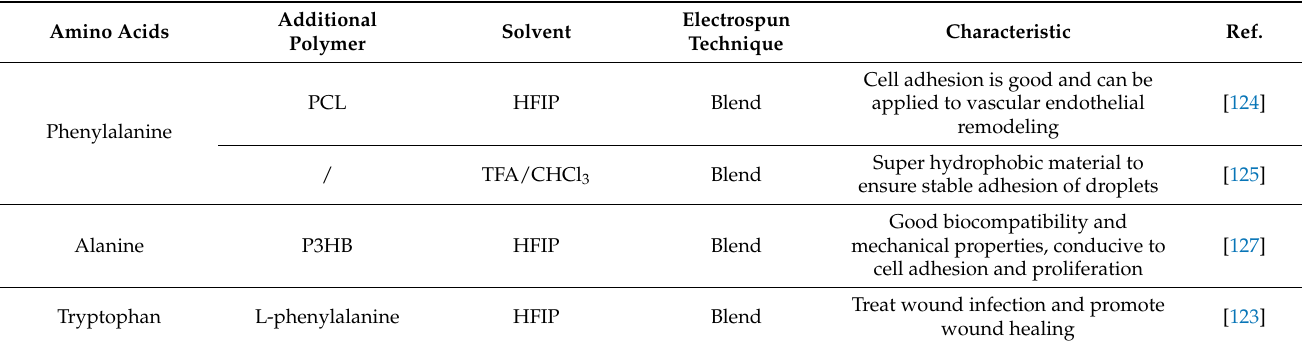
Table 3. Electrospinning conditions and characteristics of common nonpolar amino